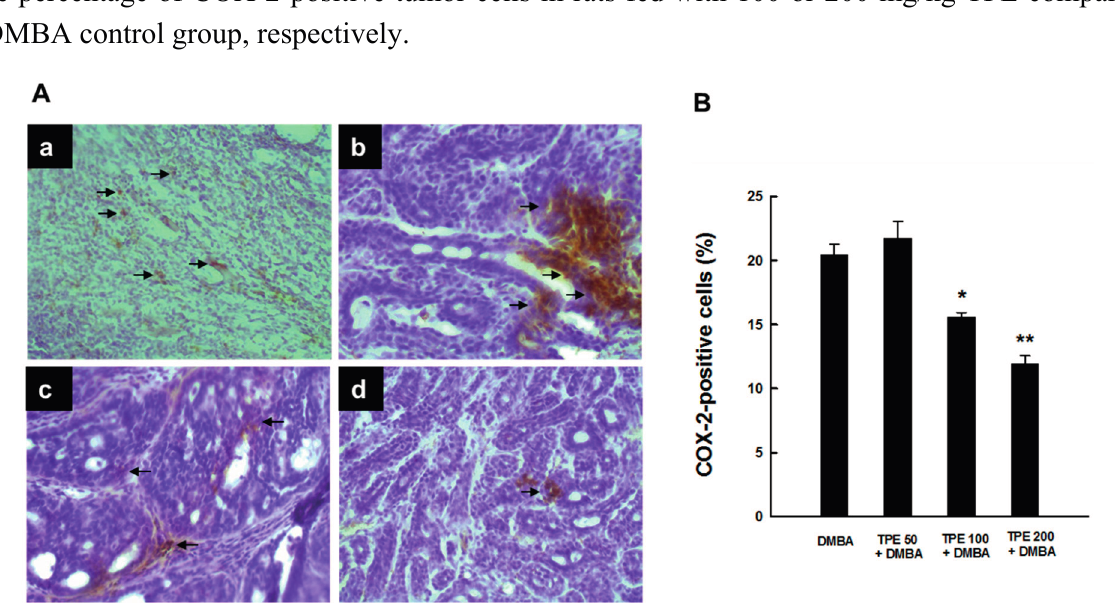
Figure 1. Effect of TPE on COX-2 expression in DMBA-induced breast tumors in female Sprague-Dawley rats. The rats had free access to food with or without TPE two